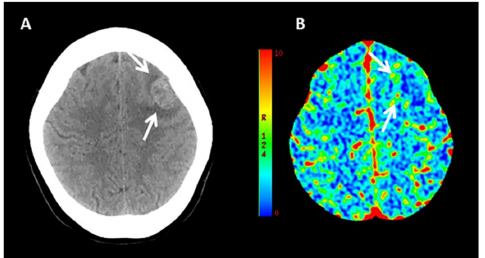
Figure 1. Example of CT Perfusion in a patient with ICH due to malignancy. Non-contrast CT (NCCT) scan ( A ) and cerebral blood volume (CBV) map ( B ) in a patient with acute ICH due to the bleeding of an underlying high grade glioma located left frontal lobe and characterized by elevated CBV values in the perihematomal region